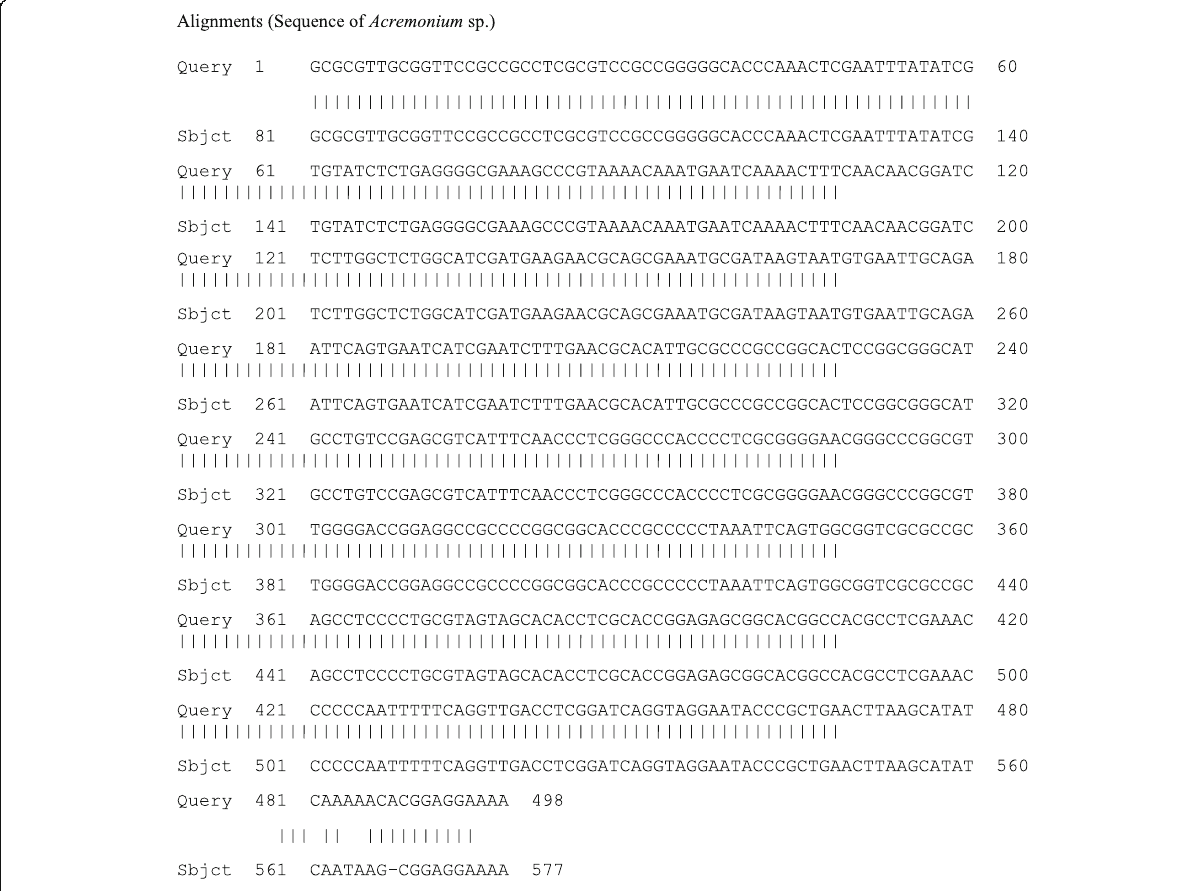
Fig. 3 18S ribosomal RNA gene, partial sequence; internal transcribed spacer1 and 1.5.8S ribosomal RNA gene, complete sequence; and internal transcribed spacer 2, partial